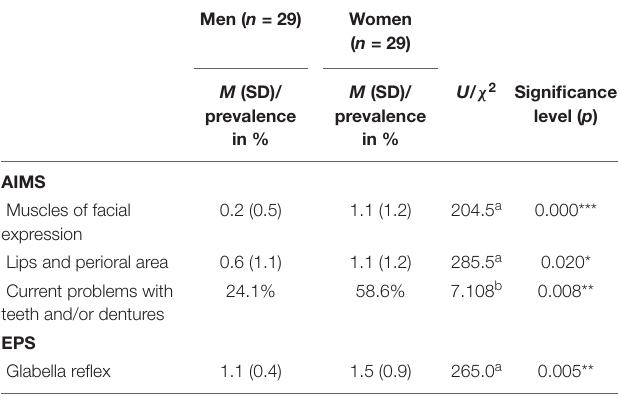
TABLE 3 | Differences in the neurological characteristics between male and female forensic in-patients with schizophrenia.